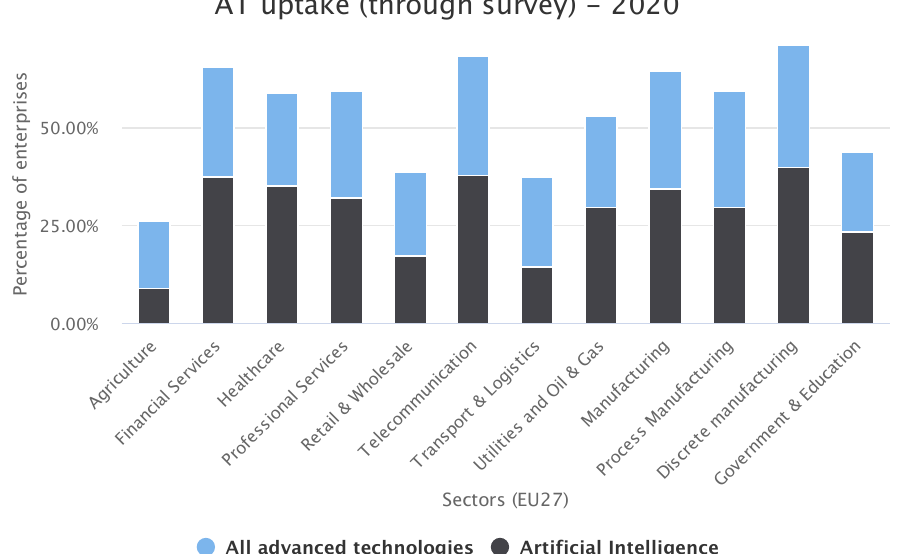
Figure 2. Percentage of advanced technology uptake in Industry 4.0 and AI in this uptake. Generated with https://ati.ec.europa.eu/data-dashboard (accessed on 8 April 2021).